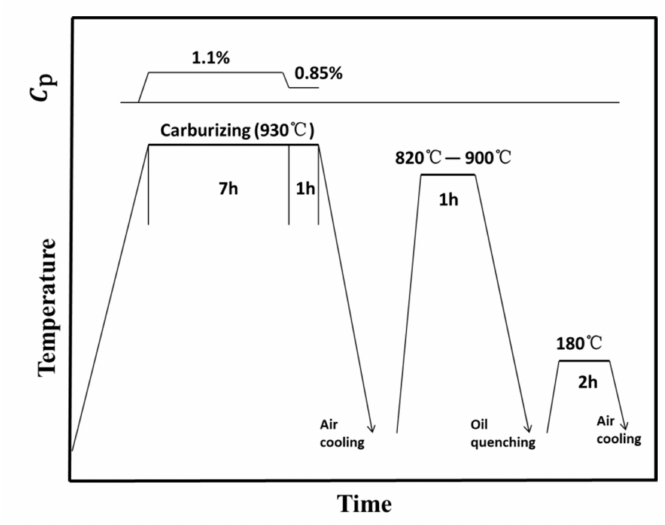
Figure 2. Schematic illustration of the vacuum carburizing and heat treatment processes of the experi- mental steel, where C p shows the expected equivalent carbon potential during the carburizing